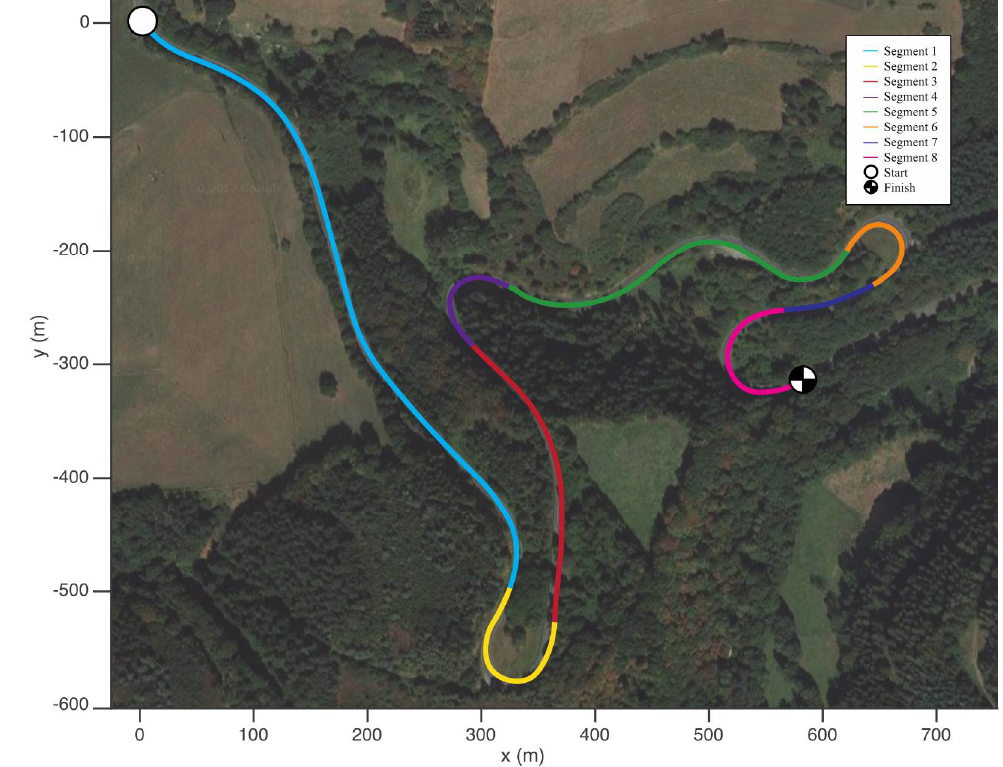
Figure 2. Location of the experiment is a 1.85 km part of road of the L281 near Vossenack, Germany. The average gradient of the descent is 5 degrees. Start location is at the top left. The descent is divided into eight segments to compare rider technique for different elements (e.g., straight parts, left hand corners, right hand